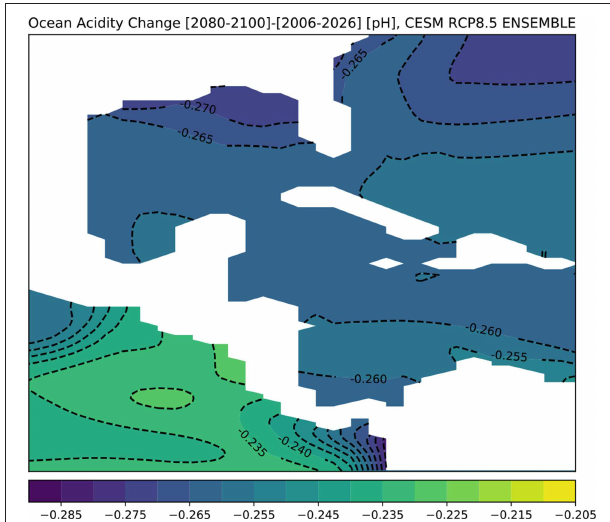
FIGURE 8 | Simulated changes in GoM pH in the RCP8.5 Large Ensemble, CESM1.2. (2080–2100 mean minus 2006–2026 mean). Continental regions are shown in